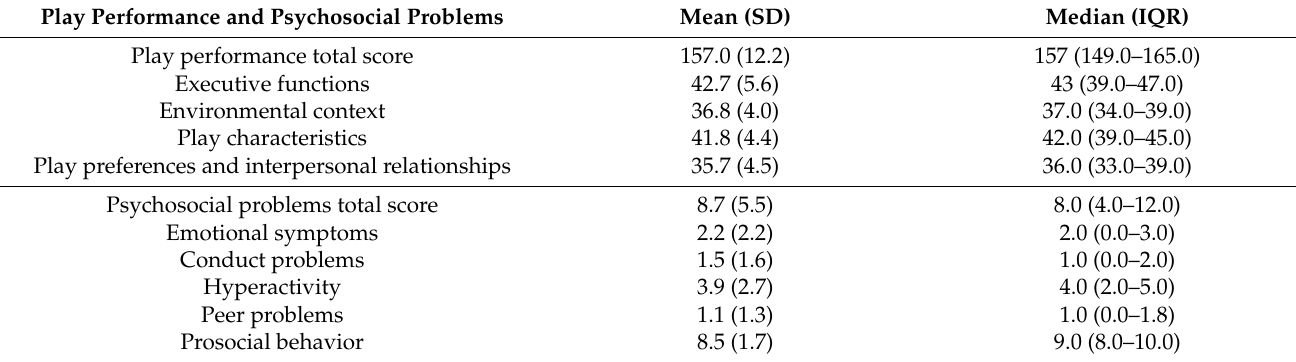
Table A1. Descriptive results for the MCP and the SDQ ( n =